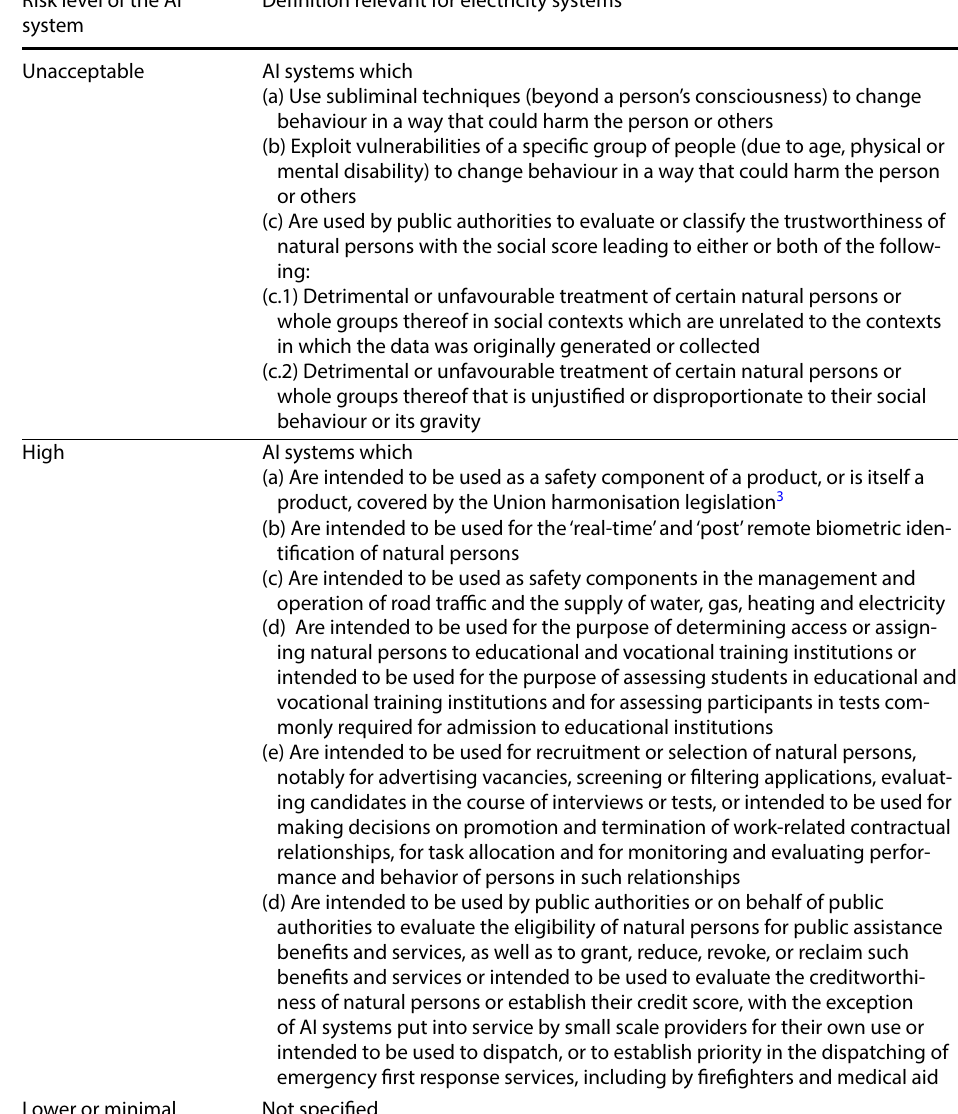
Table 1 Different risk levels as conceptualized by the EU in the EU AI Act. Source: author, based on